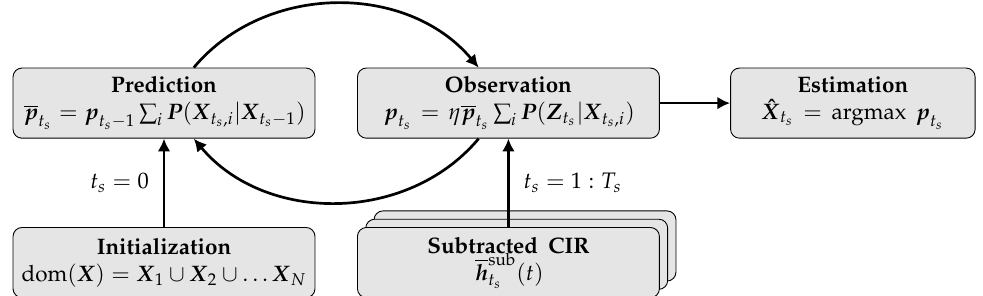
Figure 7. Flowgraph of probability grid mapping.